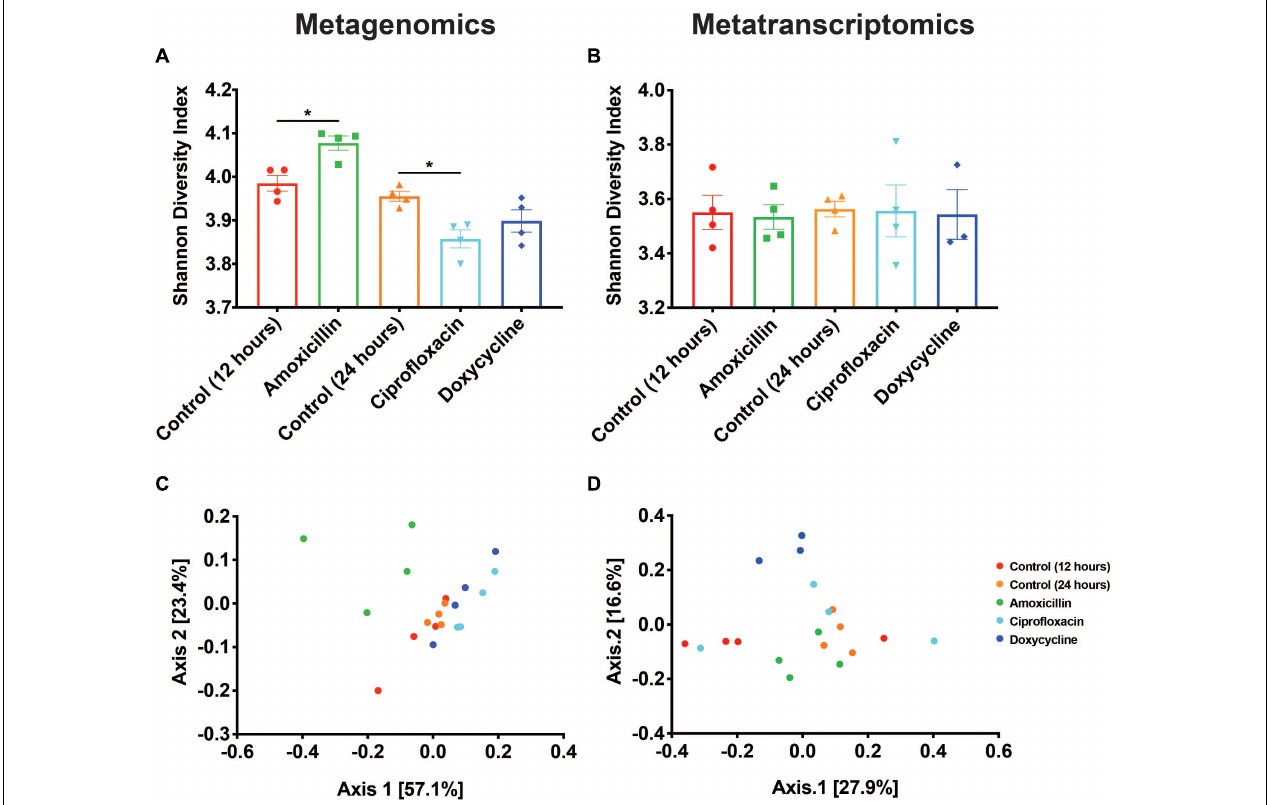
FIGURE 2 | Antibiotics have variable impacts on the diversity and structure of the resistome. (A,B) Shannon diversity index based on resistance gene counts displayed as mean ± SEM for both metagenomic and metatranscriptomic data (* p < 0.05 Mann-Whitney U test). (C,D) PCoA based on Bray-Curtis of resistance gene counts for both metagenomic and metatranscriptomic